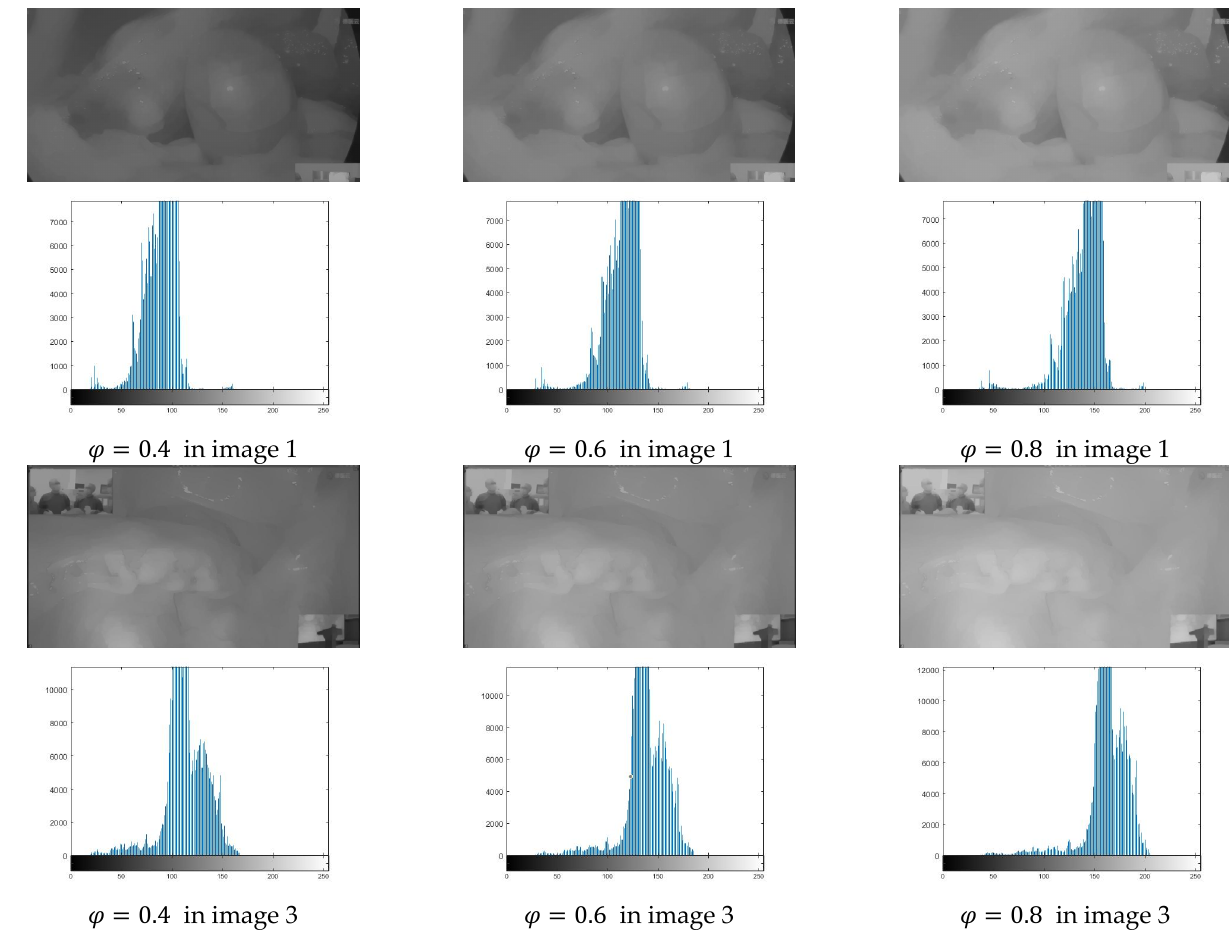
Figure 9. Histogram of the image’s V-channel corresponding to various values of 𝜑 .